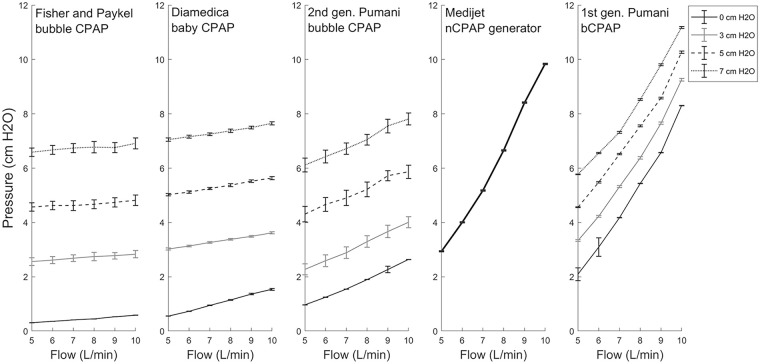
Pressure at patient interface vs. flow rate for (A) Fisher and Paykel bubble CPAP; (B) Diamedica baby CPAP; (C) second generation Pumani bubble CPAP; (D) Medijet nCPAP generator; (E) first generation Pumani bCPAP.Relationships are shown at 0 (solid black), 3 (solid gray), 5 (dashed black), and 7 (dotted black) cm of submersion in H2O. For the Medijet, only one value (solid black) is shown. Error bars represent one standard deviation. Data in S1 Table.